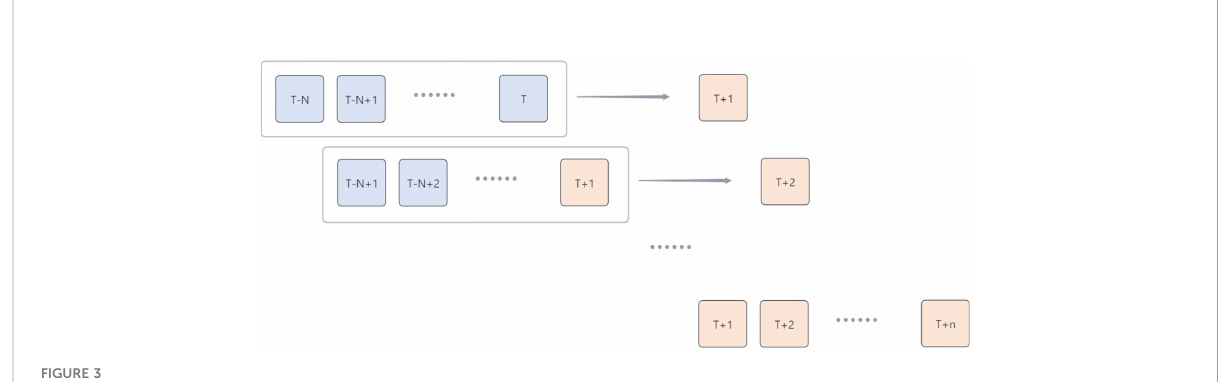
FIGURE 3 The prediction method integrated with